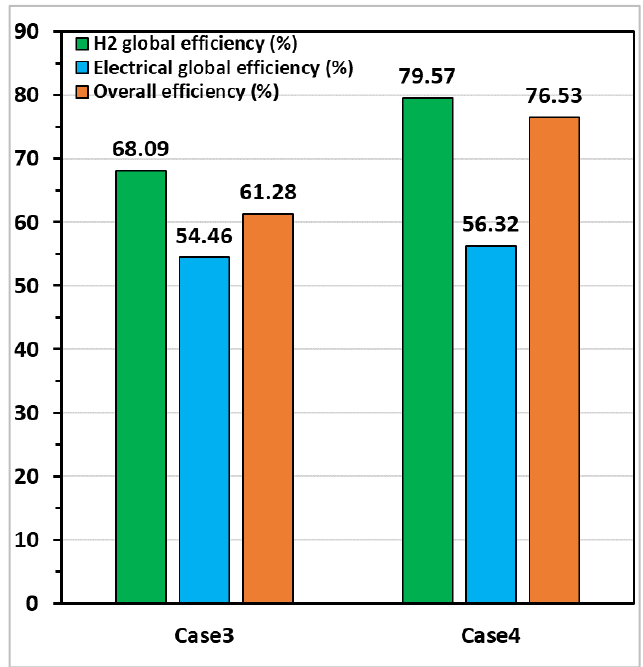
Figure 10. Performance of cases 3 and 4 producing both power and H 2 using Equations